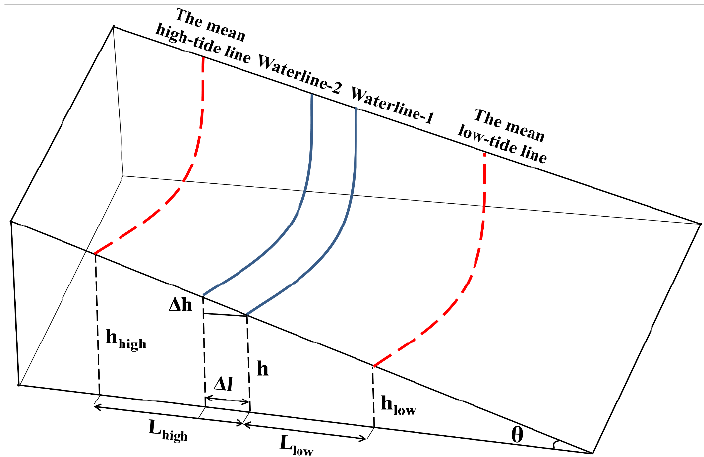
Figure 3. Principle of tidal correction. Table 1. Tidal information calculated by the remote sensing images at the scene center time.